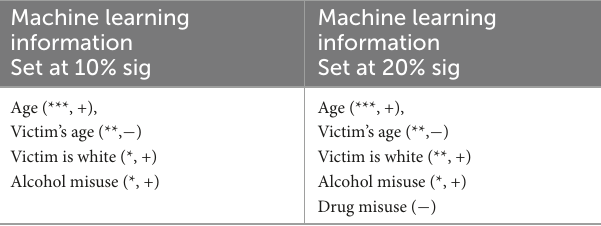
TABLE 8 Propensity score matching machine learning information set (West Midlands